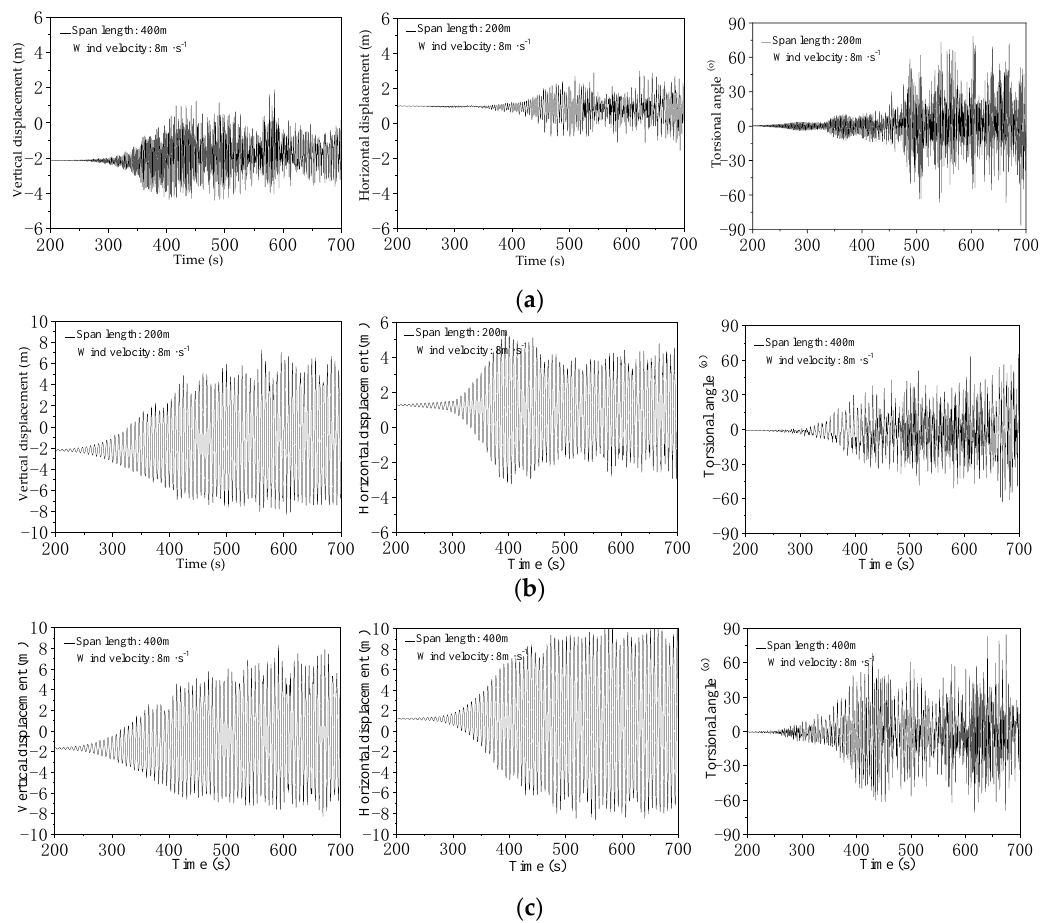
Figure 8. The amplitude of phase A of each span conductor under different suspension methods: ( a ) First span midpoint displacement time history; ( b ) Second span midpoint displacement time history; ( c ) Third span midpoint displacement time history.